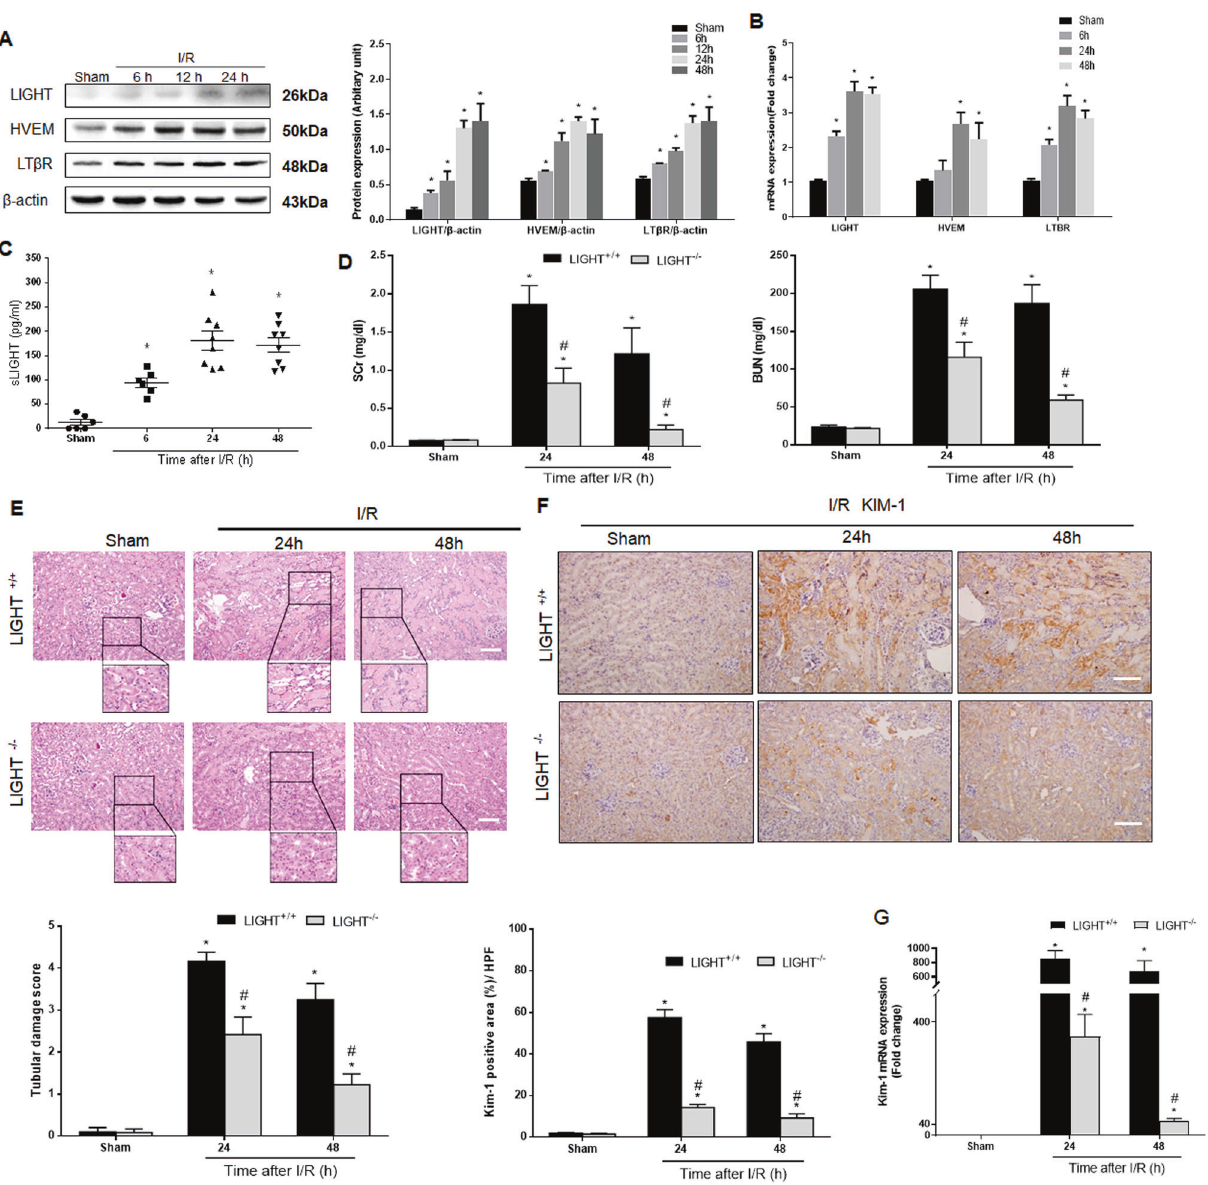
Fig. 1 LIGHT-dependent pathway is required for the pathogenesis of ischemia-reperfusion-induced acute kidney injury. A – C LIGHT + / + mice received 35 min of renal ischemia (clapping bilateral renal pedicles) followed by reperfusion for indicated time points. LIGHT and its receptor (HVEM and LT β R) expression were assessed by WB ( A ) and qPCR ( B ). C Plasma LIGHT concentration was tested by ELISA. ( n = 6 – 8 for each group). D – G Wild-type (LIGHT + / + ) and LIGHT knockout (LIGHT − / − ) mice were conducted with renal ischemia followed by reperfusion for 24 or 48 h. D Measurements of serum Scr and BUN. E H&E staining and quanti fi cation of tubular damage score. Scale bar, 50 μ m. F IHC staining and quanti fi cation for Kim-1 expression in kidney sections. Scale bar, 50 μ m. G Kim-1 mRNA levels in renal tissue were tested. Values are presented as mean ± SEM. ( n = 6 – 8 for each group). Differences between the two groups were assessed with Student ’ s t test. * p < 0.05 vs. sham group; # p < 0.05 vs. LIGHT + / + mice with